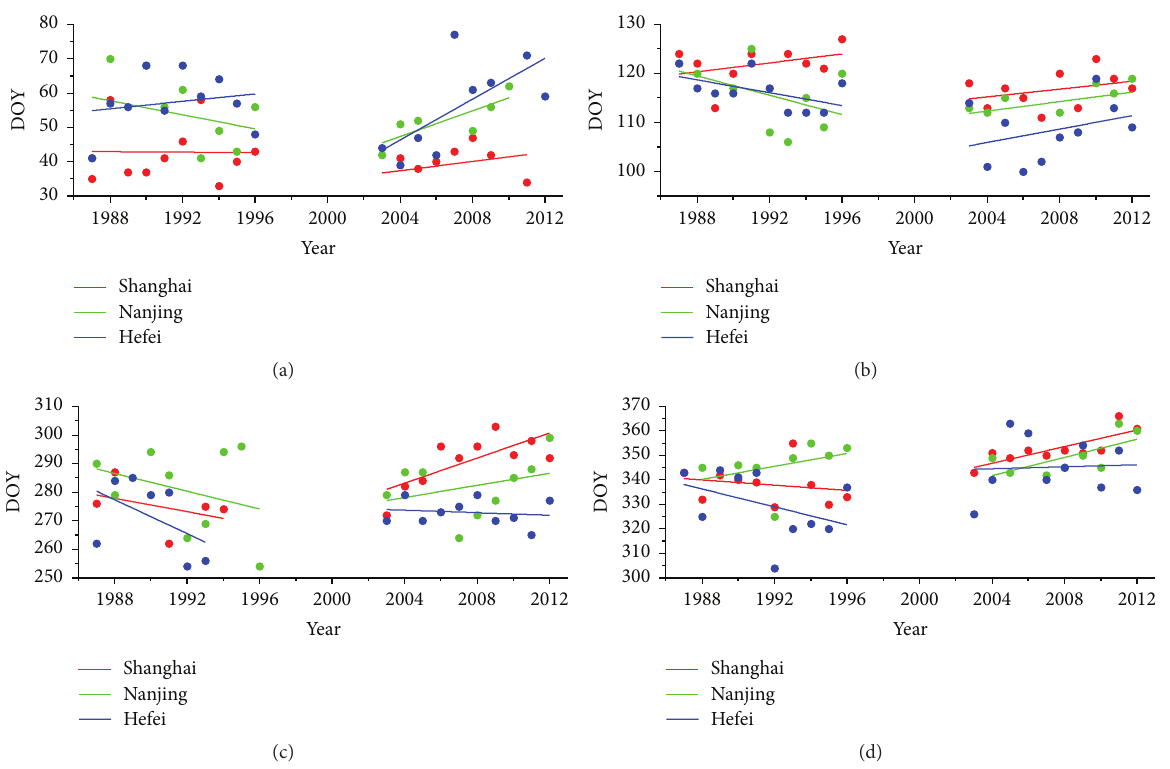
Figure 2: The changing trends in the beginning time of phenological seasons. (a) Spring; (b) summer; (c) autumn; and (d) winter. DOY: day of the